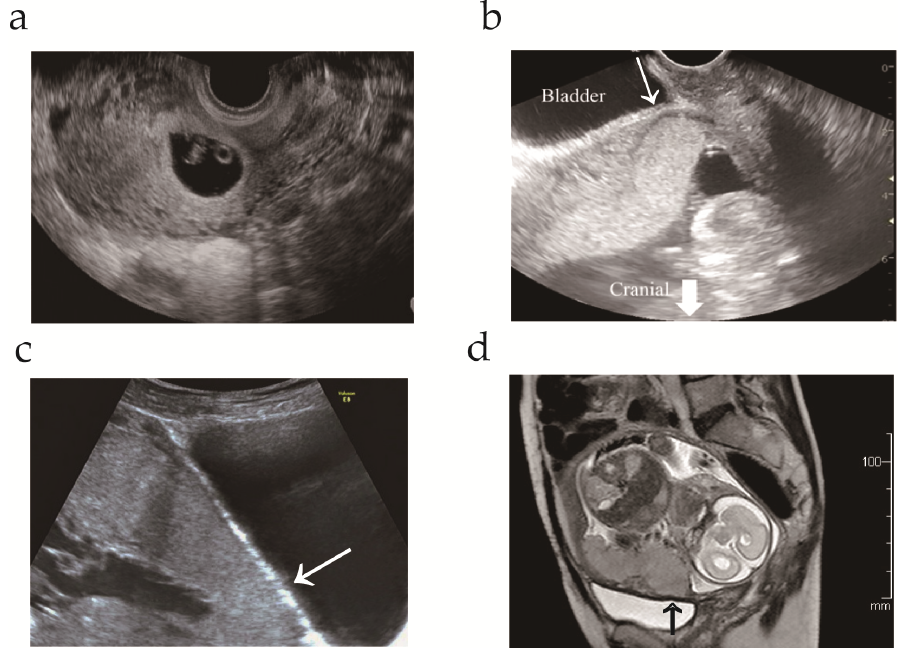
Figure 1. Transvaginal and magnetic resonance imaging during pregnancy. ( a ) Transvaginal ultrasonogram at 8 weeks’ gestation revealing a gestational sac located in the lower uterine segment; ( b ) Transvaginal ultrasonogram at 13 weeks’ gestation revealing decreased space (arrow) between the placenta and bladder; ( c ) Transabdominal ultrasonogram at 33 weeks’ gestation. The arrow indicates the loss of the normal hypoechoic retroplacental zone; ( d ) T2 magnetic resonance image at 25 weeks’ gestation. The arrow indicates the loss of the thin, dark subplacental myometrium zone.